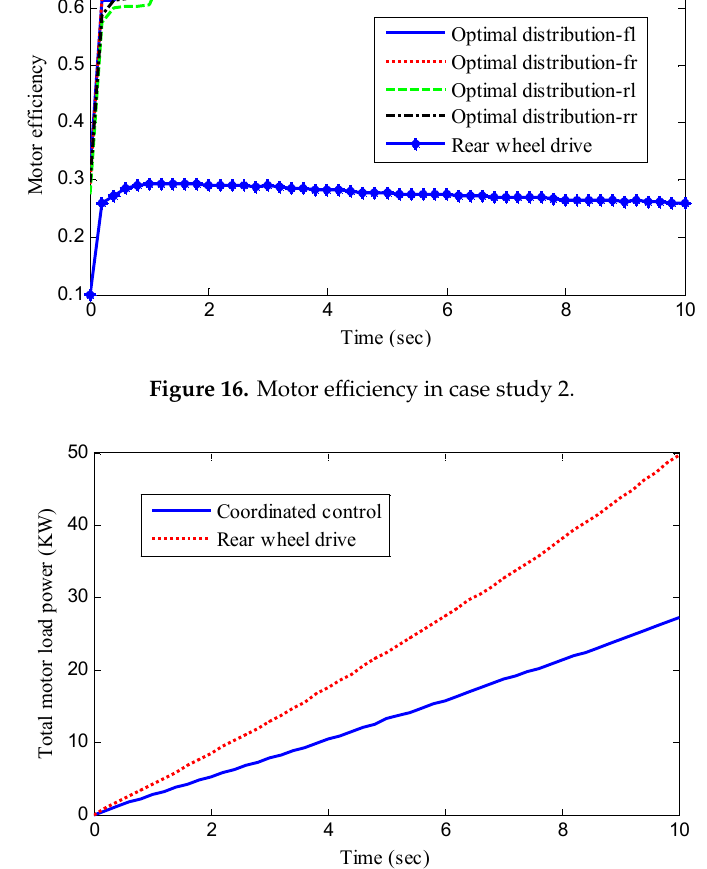
Figure 17. Total motor load power in case study 2.